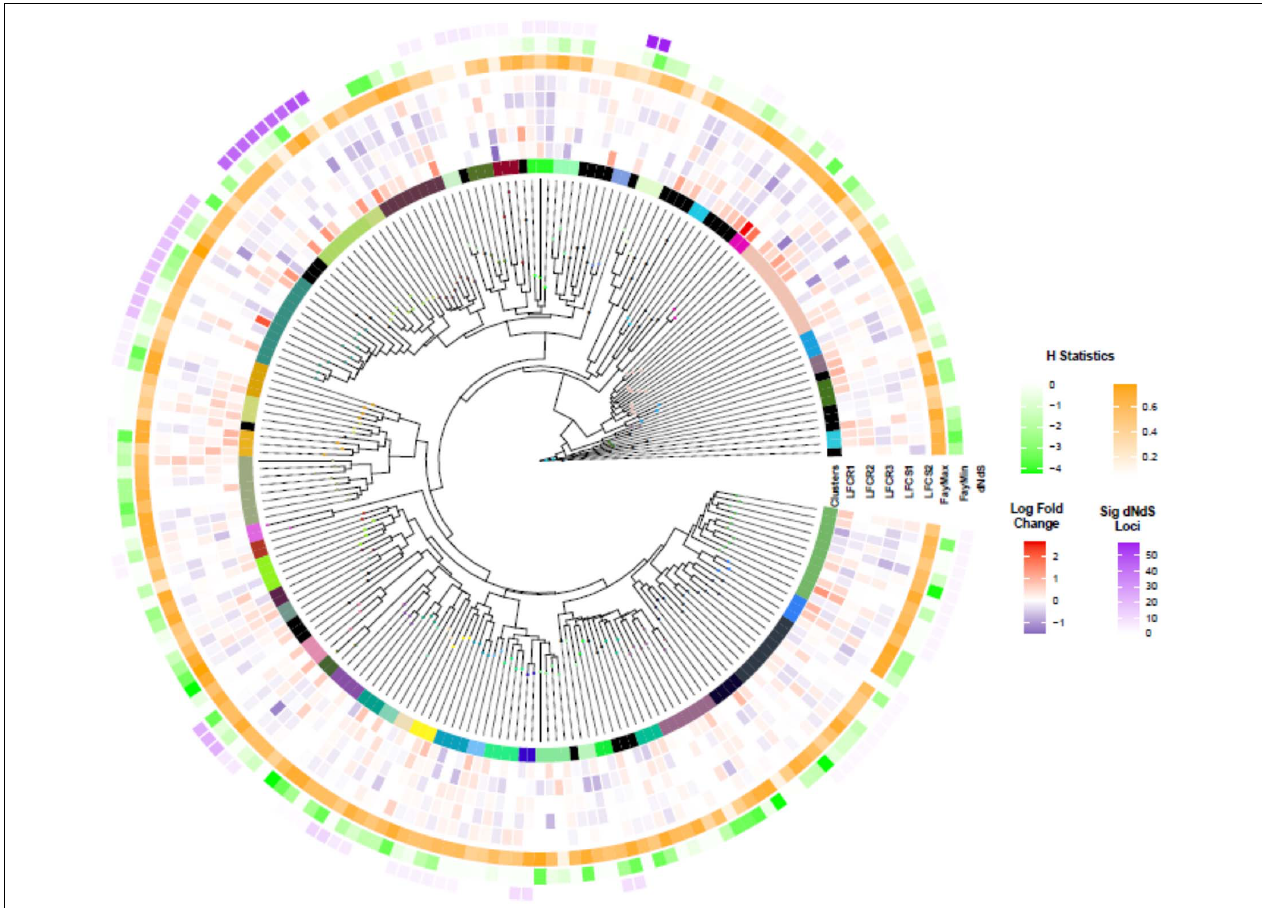
FIGURE 6 | Nucleotide-binding–leucine-rich repeat (NLR) transcripts: clustering, differential expression, dN/dS, and Fay H statistic. The phylogenetic tree of NB-ARC domain of NLR transcripts. The different colors in the innermost circle illustrate cluster assignments (track denoted as “Clusters”). The next tracks show the log 2 fold change (LF) of the transcript in each of the five genotypes (LFCR1-3, LFCS1-2; R, resistant; S, susceptible). FayMax and FayMin show minimum and maximum value of H statistic. Finally, dN/dS illustrates the number of loci with significant dN/dS value in each cluster, the color intensity is proportional to the number of